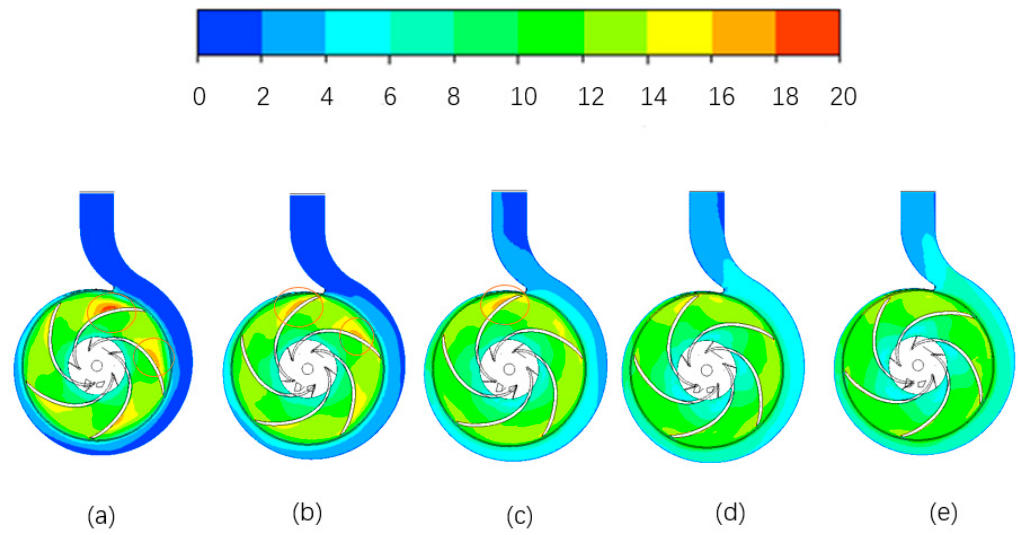
Figure 18. The internal velocity evolution of the pump during the valve opening process: ( a ) t = 8 s, ( b ) t = 8.1 s, ( c ) t = 8.2 s, ( d ) t = 8.3 s, ( e ) t = 8.4